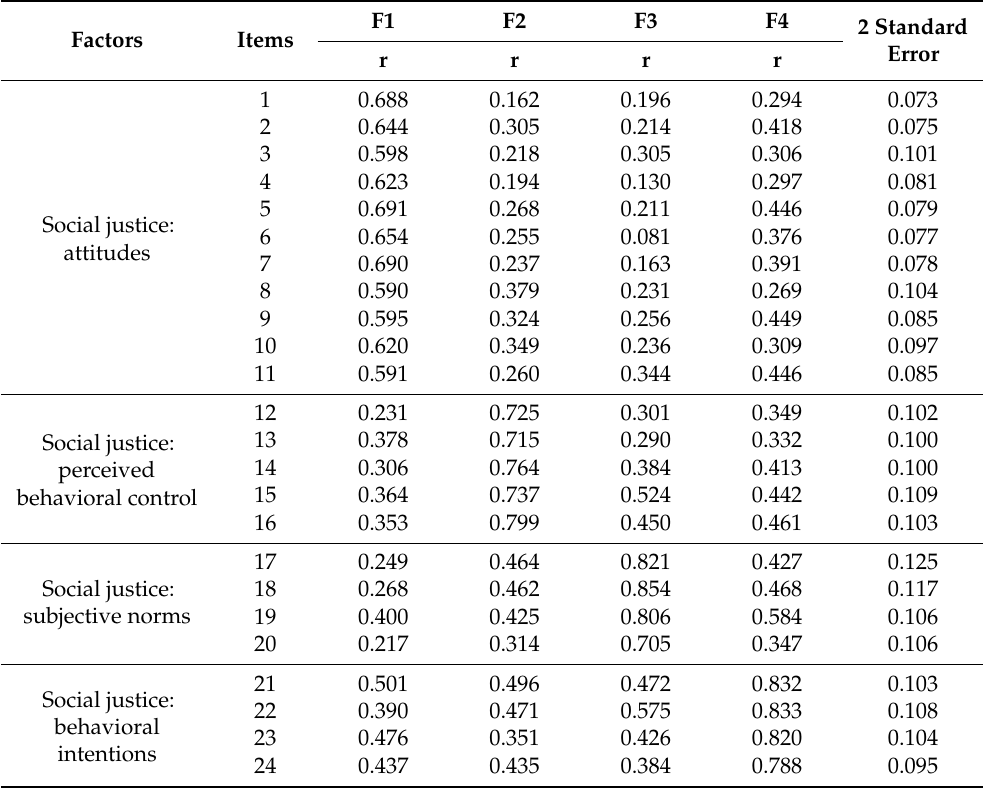
Table 3. Multi-trait/Multi-item Matrix Analysis ( N = 267).